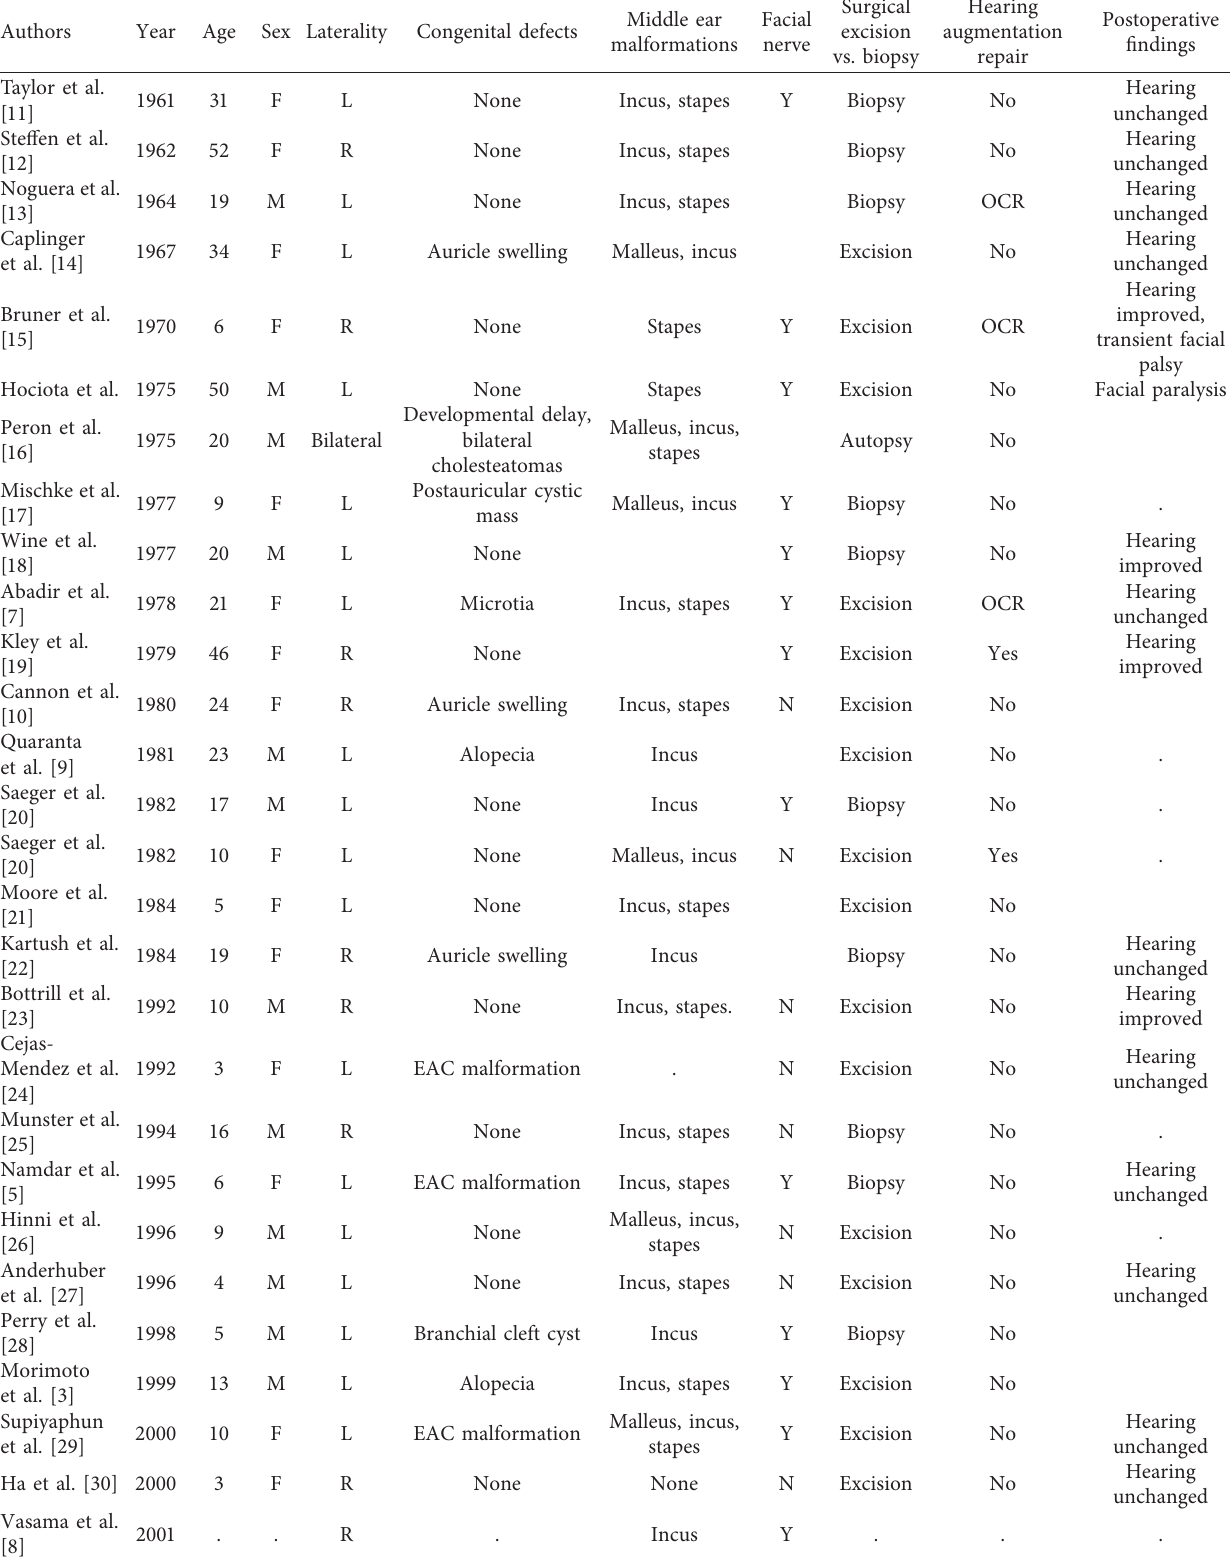
Table 1: Review of middle ear salivary choristomas and